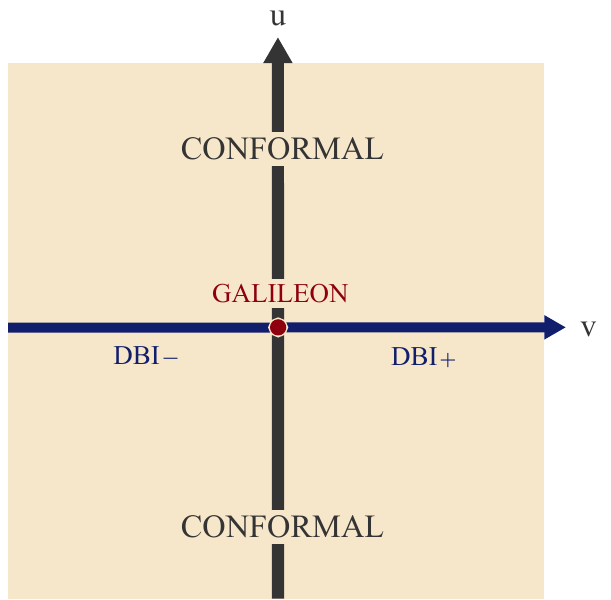
Figure 3 . The \phase diagram" of allowed theories with a single physical NG boson and a vector of redundant generators K (cid:22) as speci(cid:12)ed by the commutation relations (3.10). The DBI + and DBI (cid:0) symbols refer to DBI theories based on the orthogonal group SO(3 ; 2) and SO(4 ; 1),